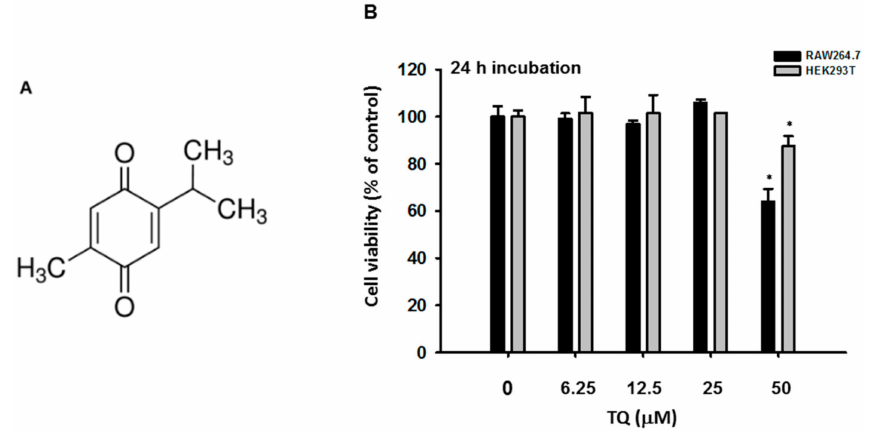
Figure 1. Chemical structure and viability profiles of thymoquinone (TQ). ( A ) Chemical structure of TQ; ( B ) RAW264.7 and HEK293T cells (10 5 cells/well) were treated with TQ at the indicated doses for 24 h, and cell viability was determined by a 3-(4,5-dimethylthiazol,2-yl)-2,5-diphenyltetrazolium bromide (atetrazole) (MTT) assay. All data are expressed as the mean ± SD. * p < 0.05 compared to the normal